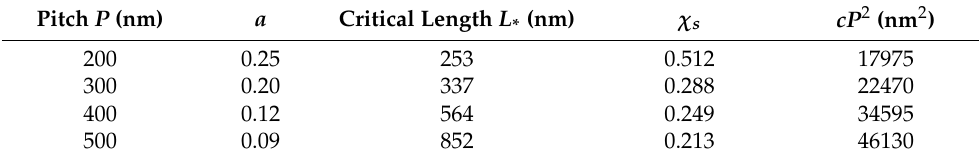
Figure 4. ( a ) Length of 26–27.5 nm radius InAs NWs versus time for different pitches 𝑃 shown in the legend (symbols) [20], fitted by Equations (8) and (12), with the parameters summarized in Table 3 (lines). ( b ) Length–diameter correlation of InAs NWs grown for 30 min in 300 nm pitch array (symbols) [20], fitted by the model (line). Table 3. Parameters of pitch-dependent growth kinetics of Au-catalyzed InAs NWs.